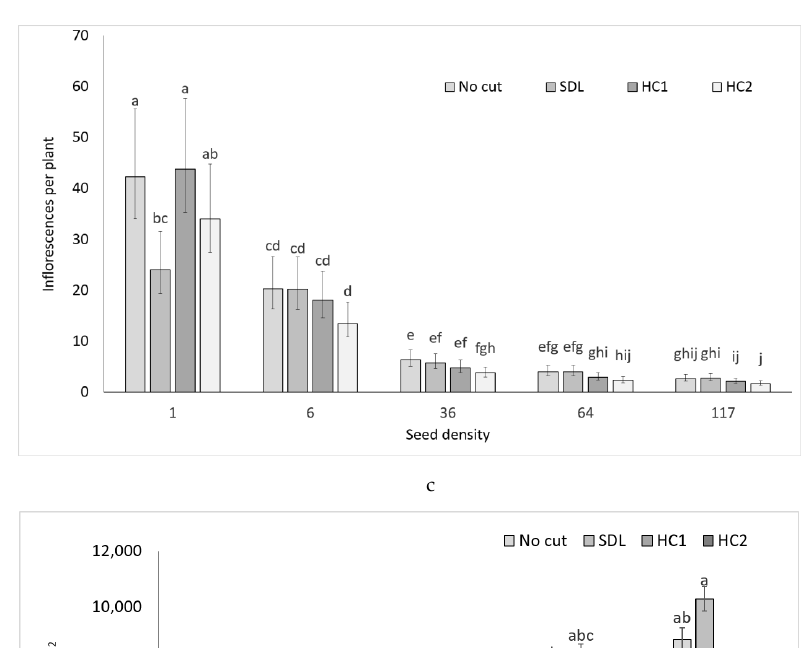
defoliation (HC2), and this was observed at all densities over a single plant grown alone (Figure 6c). At intermediate densities (36 and 64 plants), differences were significant (59% and 58%, respectively). At the lowest density only, defoliation at seedling stage (SDL) also produced a significant reduction in inflorescence density (57%). At plant densities of six plants and above, total fecundity was found to decline after plants were subjected to a single (HC1) and also repeated defoliation at inflorescence emergence, although impact due to repeated defoliations (HC2) was greater (Figure 6d). The greatest reduction in total fecundity was observed when plants were subjected to a repeated defoliation (HC2) at the two highest densities (64 and 117 plants) (75% and 74%, respectively). 4. Discussion The use of conservation tillage practices, continuing climate variability, and the exclusive use of certain herbicides for annual grass control are all likely to facilitate current barley grass invasion across southern Australia, enabling the recent proliferation of highly competitive biotypes [12]. Despite the utilisation of barley grass for livestock fodder during its vegetative phase, efficacious control is crucial to reduce potential for seed contamination in sheep and improve pasture productivity later in the season. However, the co-occurrence of seed dormancy and herbicide resistance in numerous barley grass populations is likely to complicate management due to limited herbicide options available [31], while prevalence in steep or rocky sites can make herbicide application impractical. Combining chemical with cultural control methods including defoliation may, thus, be valuable for reducing annual grass weed populations and consequently facilitating growth and competitive attributes of desirable pasture species.